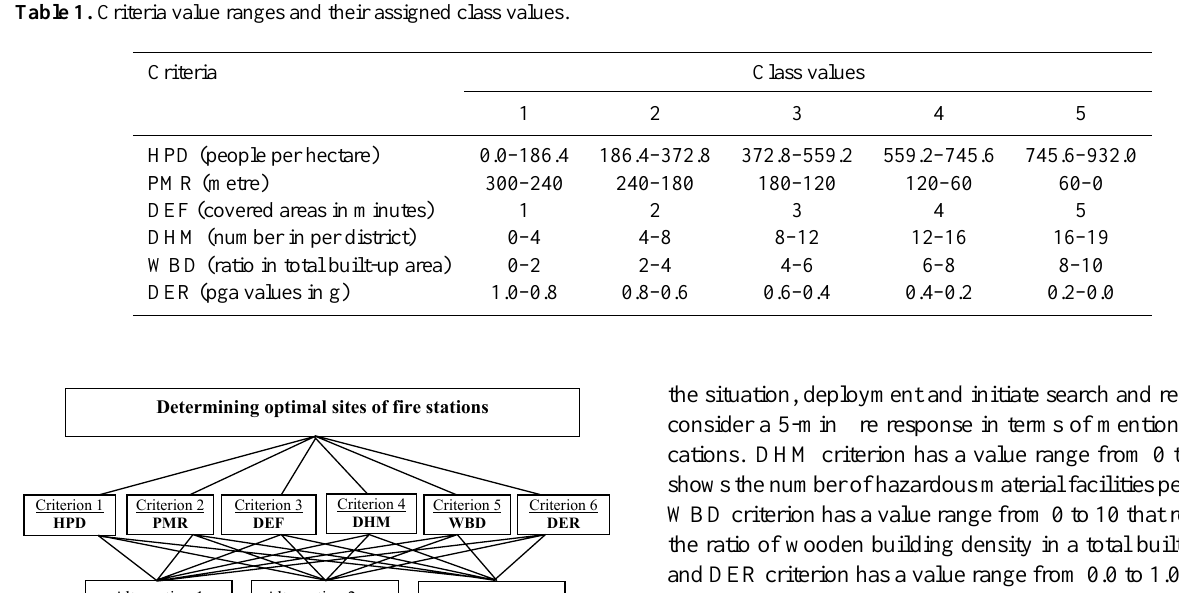
Table 1. Criteria value ranges and their assigned class values.